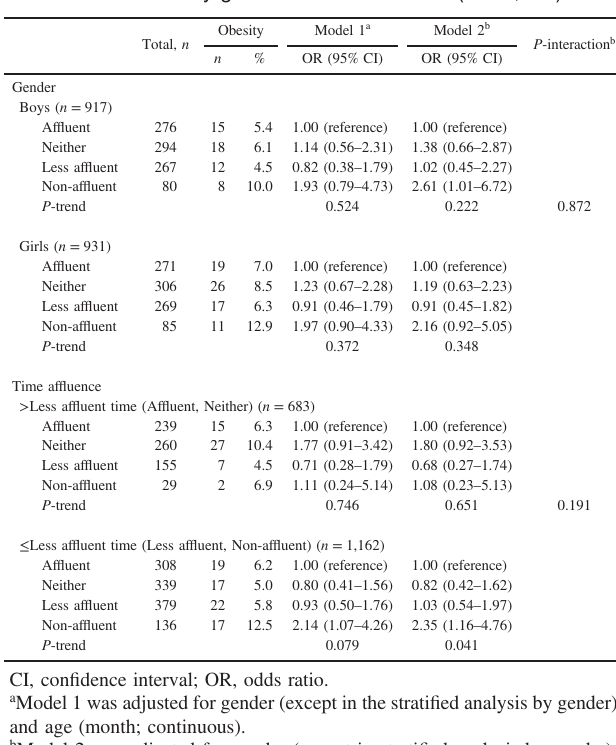
Table 3. Subjective household economic status and obesity strati fi ed by gender or time a ffl uence ( n = 1,848) Obesity Model 1 a Model 2 Total, n